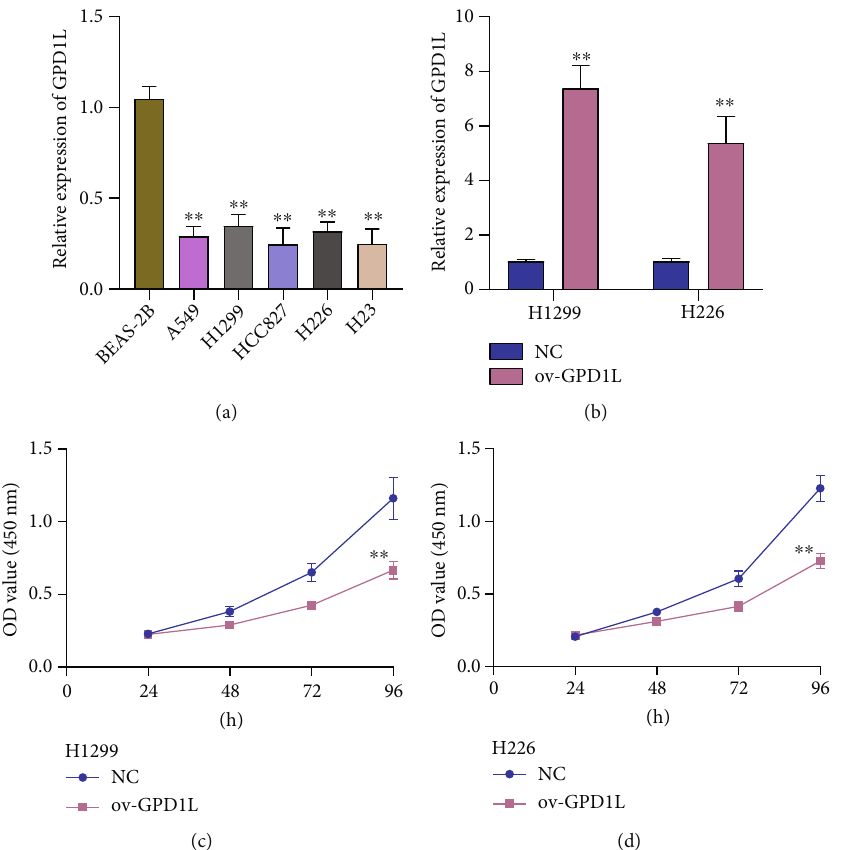
Figure 9: The overexpression of GPD1L in LUAD cells has been shown to limit cell growth. (a) The amount of GPD1L mRNA that is expressed relatively in LUAD cells (A549, H1299, HCC827, H226, and H23 cells) compared to BEAS-2B cells. (b) After treatment, there was an increase in the amount of GPD1L that was expressed in H1299 and H226. (c, d) The CCK-8 assay was utilized to determine whether or not the cells were viable. ∗ p < 0 : 05 , ∗∗ p < 0 : 01 , ∗∗∗ p < 0 : 001 ; ns: no signi fi